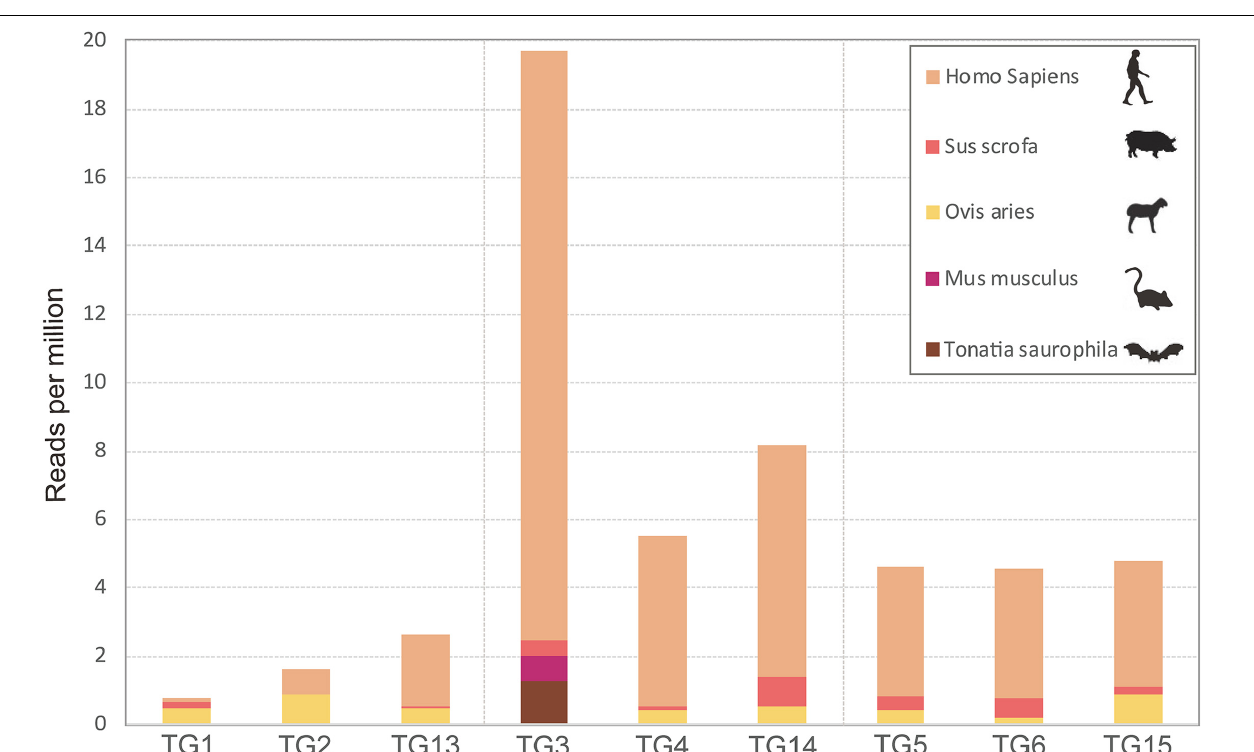
Frontiers in Microbiology |